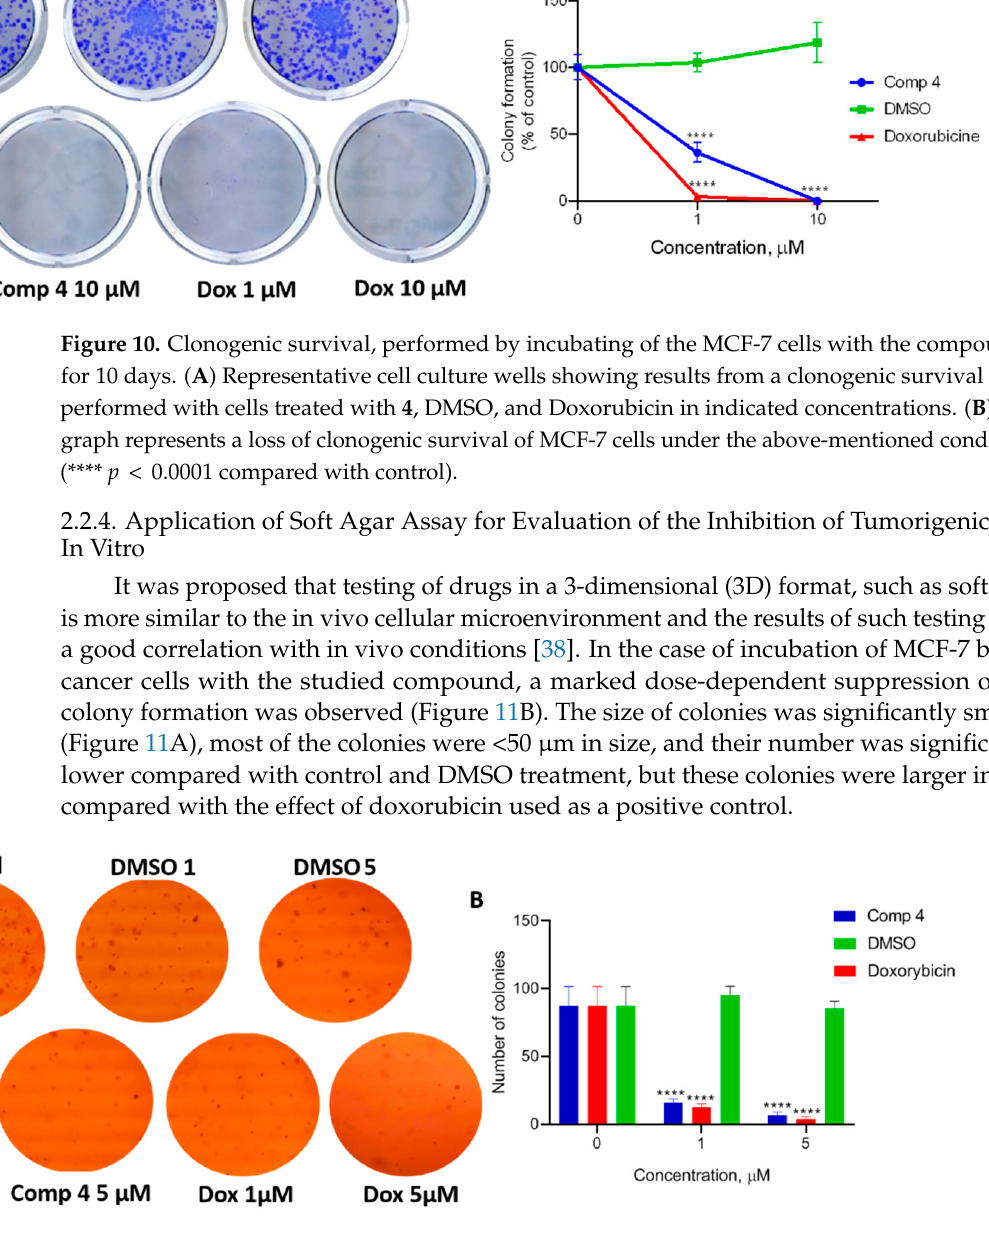
Figure 11. Compound 4 reduces the size and number of colonies of MCF-7 cells. Results of soft agar drug sensitivity assay (day 12). ( A ) Representative cell culture wells. ( B ) Graphical data (**** p < 0.0001 compared with control). The results of colony formation assay demonstrated that the compound 4 inhibited the viability of MCF-7 cells in a dose-dependent manner. These results are in agreement with the data of soft agar assay. A major advantage of this technique is that the semi-solid matrix selectively favors the viability of cells that can proliferate in an anchor- age-independent manner [39,40]. Altogether, these data indicated that the derivative 4 exhibited a significant anticancer activity against breast cancer cells.